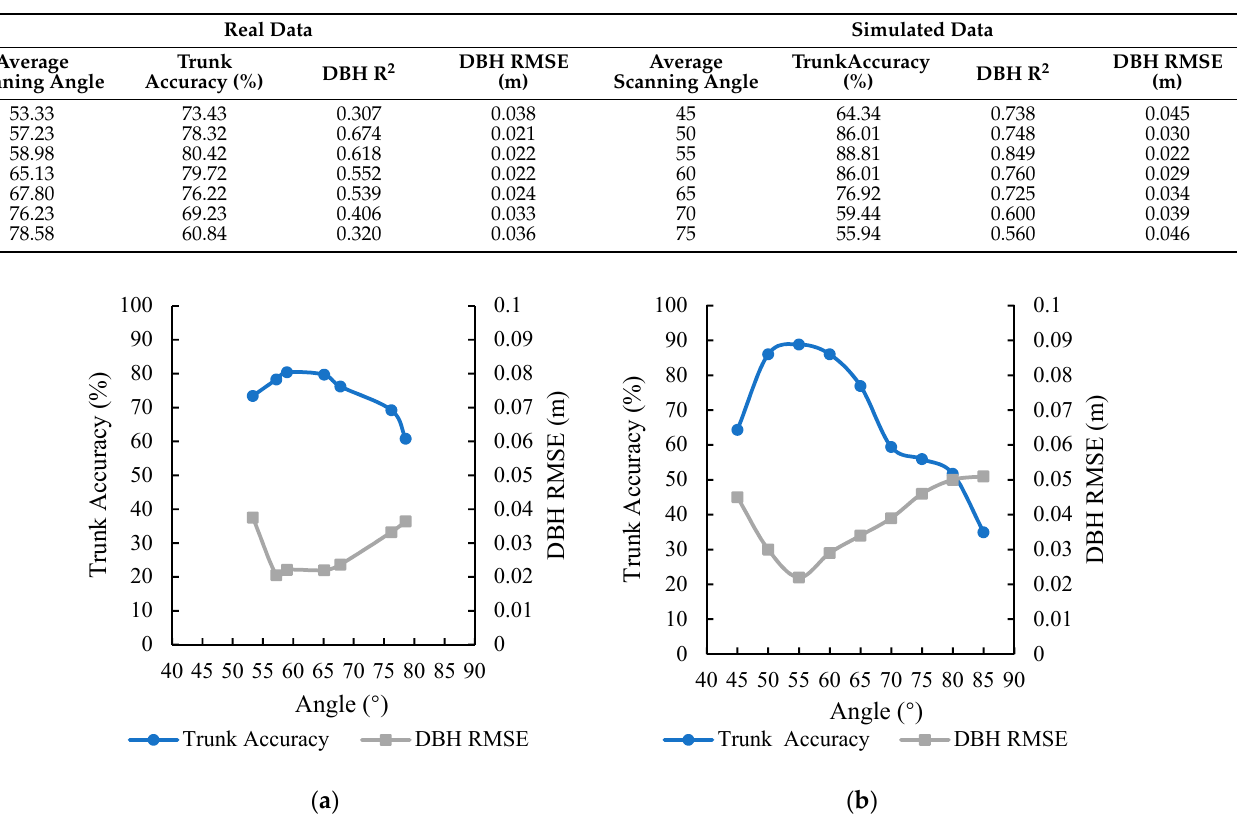
Table 5. Accuracy comparison for trunk point extraction and DBH measurement with different scanning angles in the quadruple routes mode.